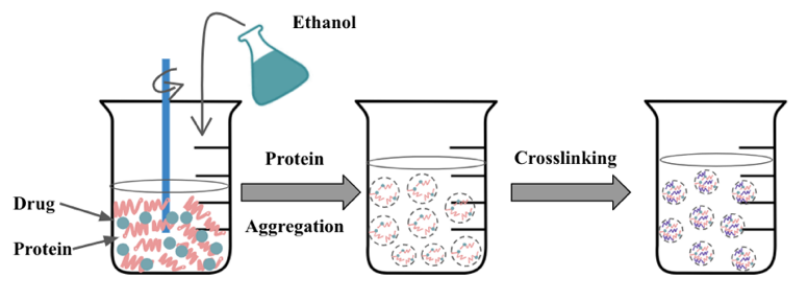
Figure 6. Self-assembly—Desolvation—Individual protein chains are dissolved in a solution at a Critical Solution Temperature which exceeds the Critical Micelle Concentration and leads to the generation of protein micelles during the nanosized aggregate formation, in the self-assembly method. In desolvation, NPs are fabricated by the addition of a desolvating agent to a protein solution which contains drugs.